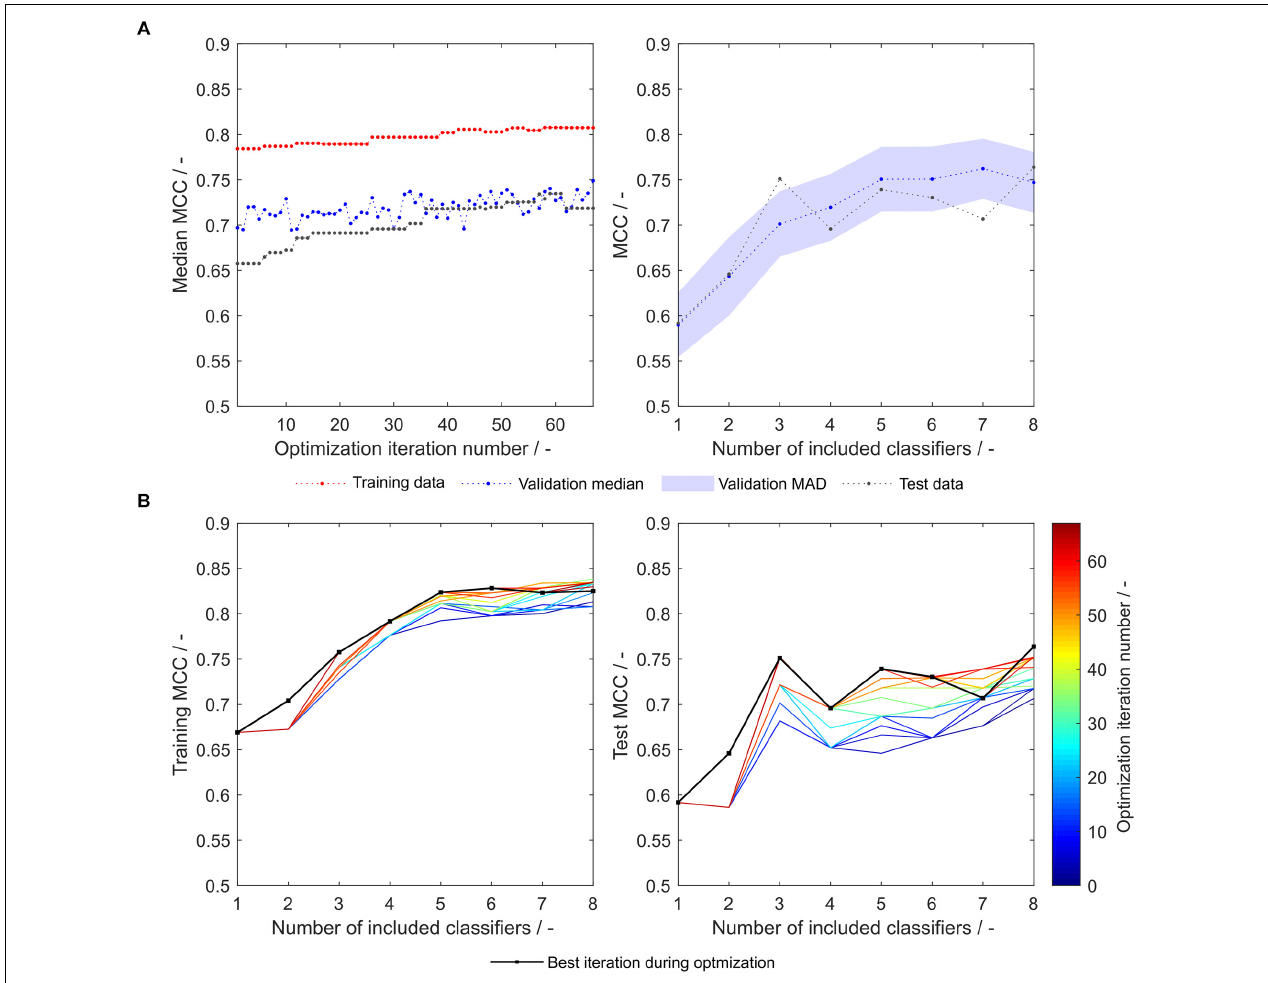
FIGURE 7 | Matthew’s correlation coefficient (MCC) during insertion strategy-based model optimization. Scales used were eight generated scales from scale table set S 8 , 1 . Median MCC are shown for training, validation, and test data over optimization iterations ( A , left). Validation and test MCC are shown over number of included classifiers in the soft ensemble vote classifier (sEVC; A , right) for the best model in the optimization procedure. The median absolute deviation (MAD) of the validation MCC above and below the median validation MCC is visualized by a shaded area. Training and test MCC over number of included classifiers are shown for the optimization iterations until the best iteration, where median validation MCC was highest (B) . Optimization iterations are illustrated by a colormap, where dark blue represents the first iteration and dark red the best iteration, highlighted by the black